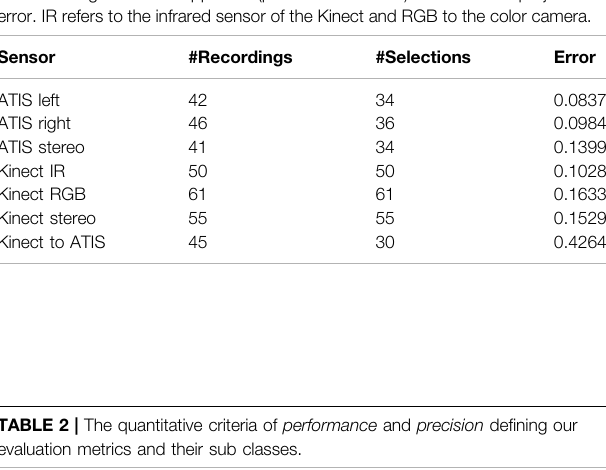
TABLE 1 | Calibration results. #recordings refers to how many images were taken in the calibration process, while #selections indicates how many pictures the